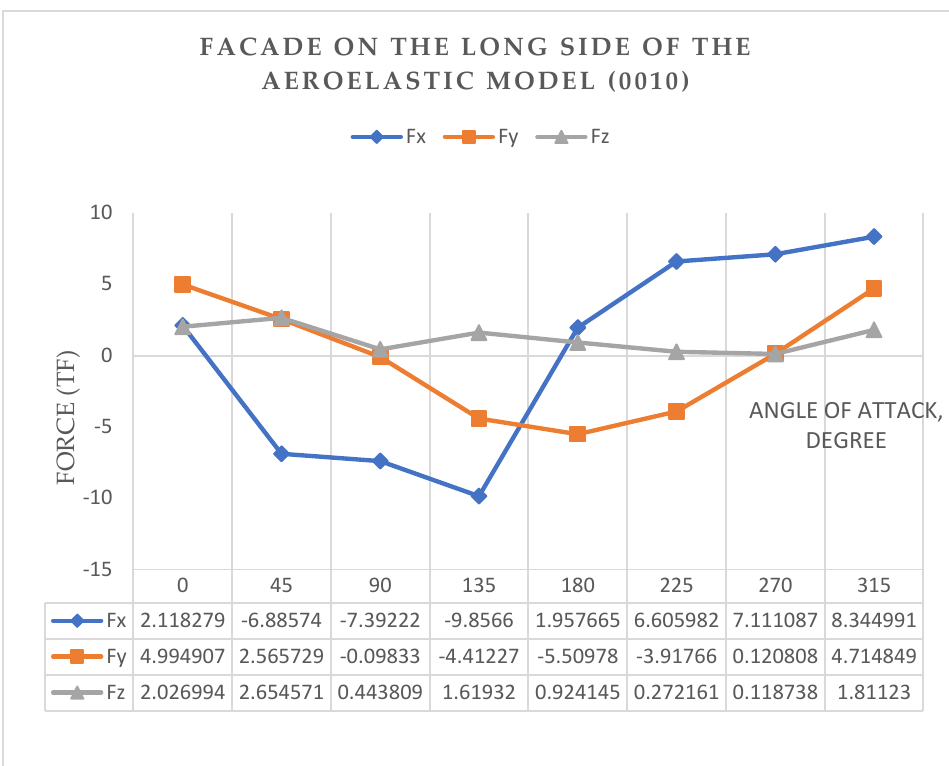
Figure 9. Force curves of Fx, Fy, Fz (tf) for a change in the angle of attack from 0° to 360°, for an open aeroelastic model with a facade on the long side, Option (0010).